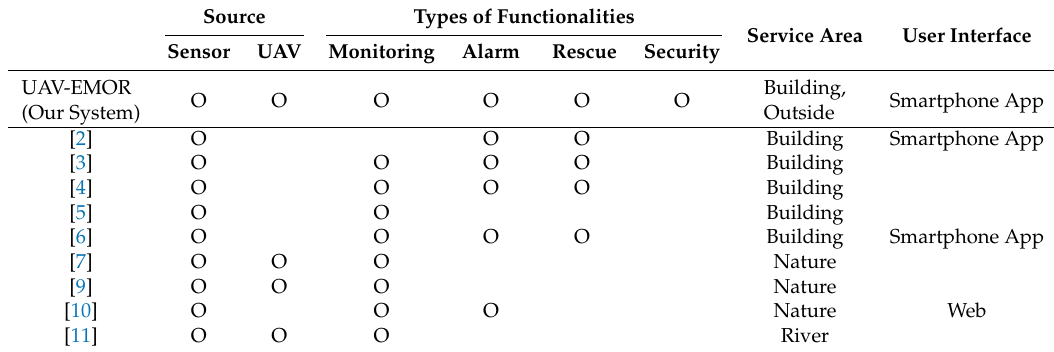
Table 1. Comparison of related works. EMOR, Emergency Monitoring and